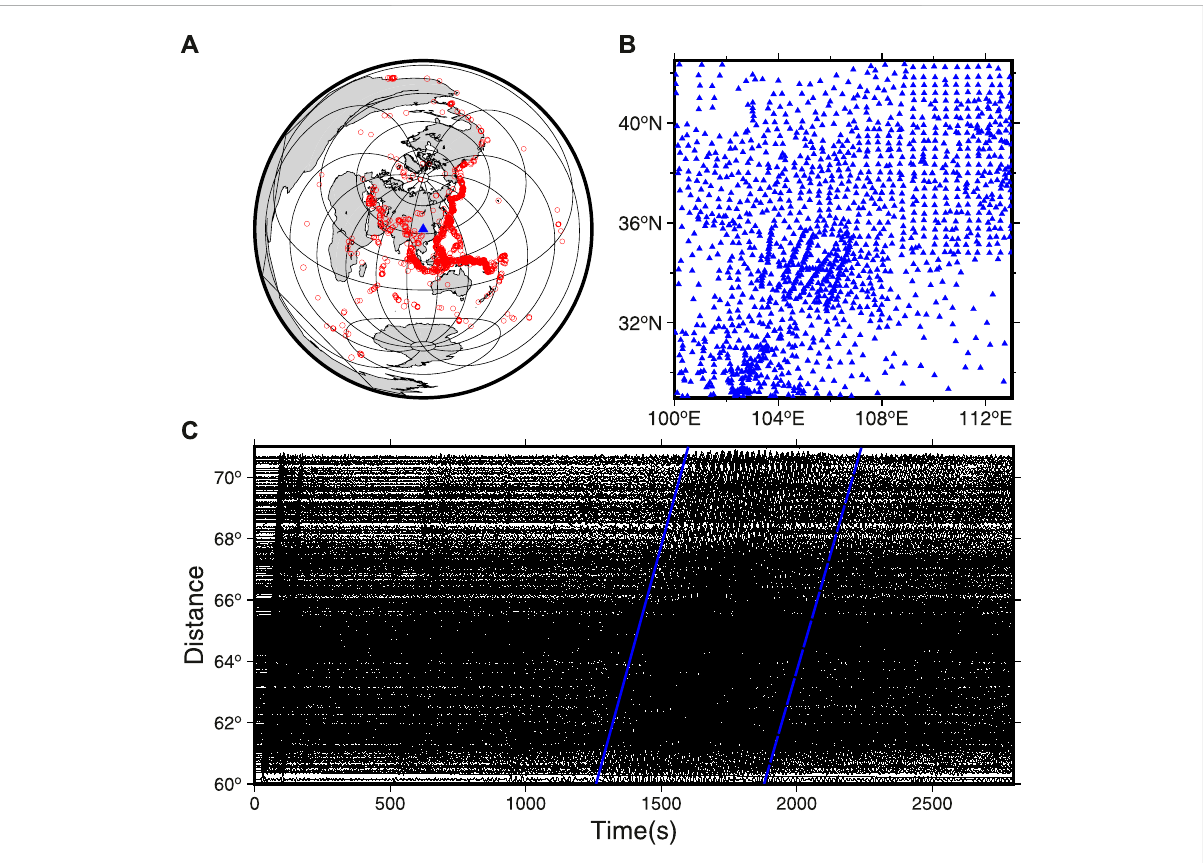
FIGURE 2 (A) Distribution of earthquakesused for surface wave tomography, (B) Distribution of stations used for surfacetomography. (C) The waveforms of the earthquake (Info: 20 April, 2014; at 7.165 ° S, 155.335 ° E, 20 km and Mw 6.2) recorded by the ChinArray-Himalaya Phase Ⅱ . The two blue lines highlight the time windows of Rayleigh wave signal with high signal-to-noise